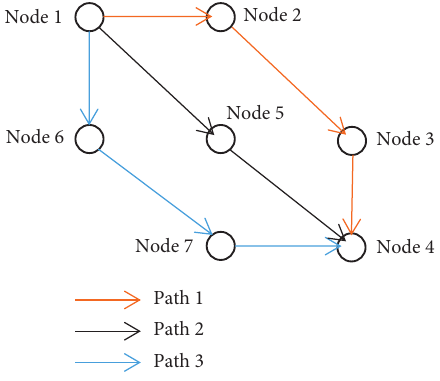
Figure 1: The system model with 7